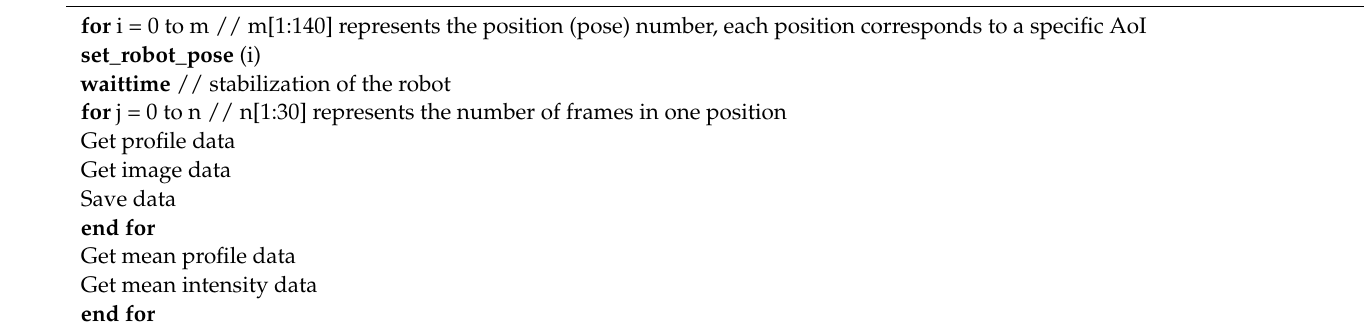
Algorithm 1. The measurement